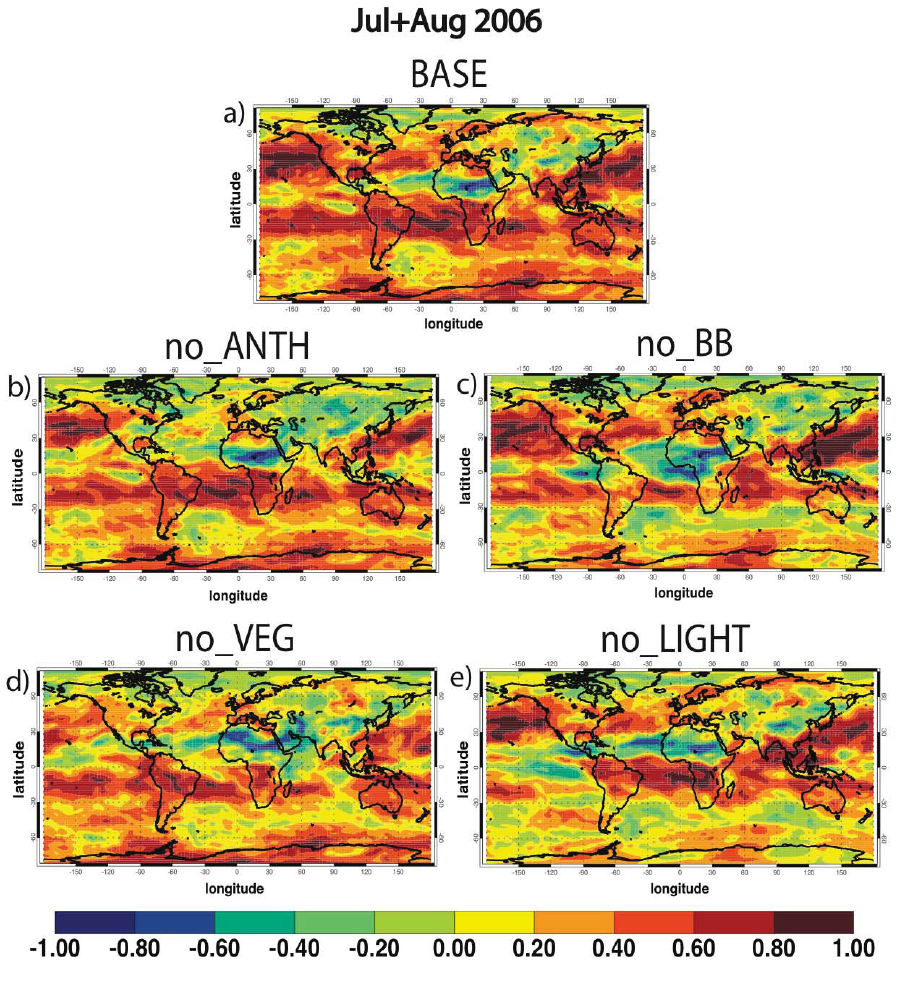
Fig. 8. Correlation coefficient of daily mean July–August 2006 middle/lower free tropospheric O 3 and CO concentrations in the BASE G-PUCCINI run (unperturbed; a ) and in 4 sensitivity runs in summer. The four runs are: (b) no anthropogenic emissions, (c) no biomass burning emissions, (d) no emissions from vegetation (isoprene, alkenes, paraffin), and (e) no lightning emissions. All model data that fall into the 800–400hPa region have been used (no time sampling/averaging kernel